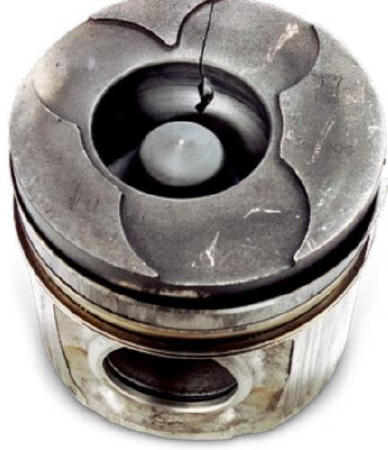
Fig. 4. Diesel engine piston with a crack on the bottom [21]